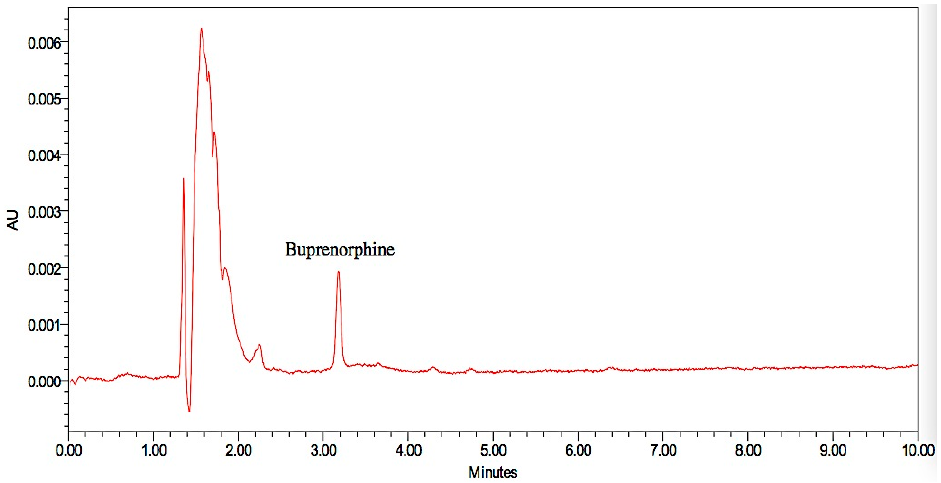
Figure 7. Representative chromatograms of the buprenorphine drug sample.